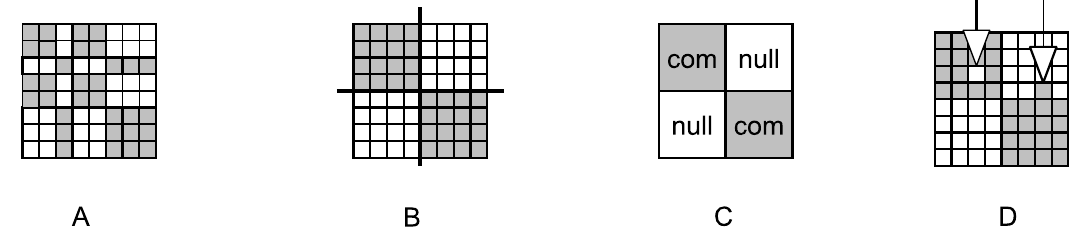
Fig 1. Example of an empirical network and its blockmodeling solution. (A) empirical network, (B) empirical network drawn in line with the blockmodeling solution, (C) blockmodel, (D) blockmodeling solution with two inconsistencies.